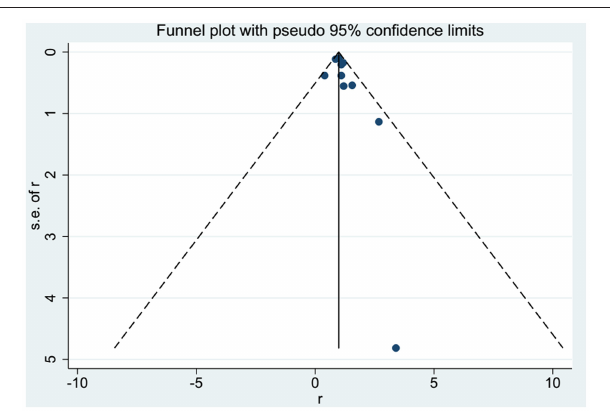
FIGURE 4 | Funnel plot for eligible studies with pseudo 95% confidence